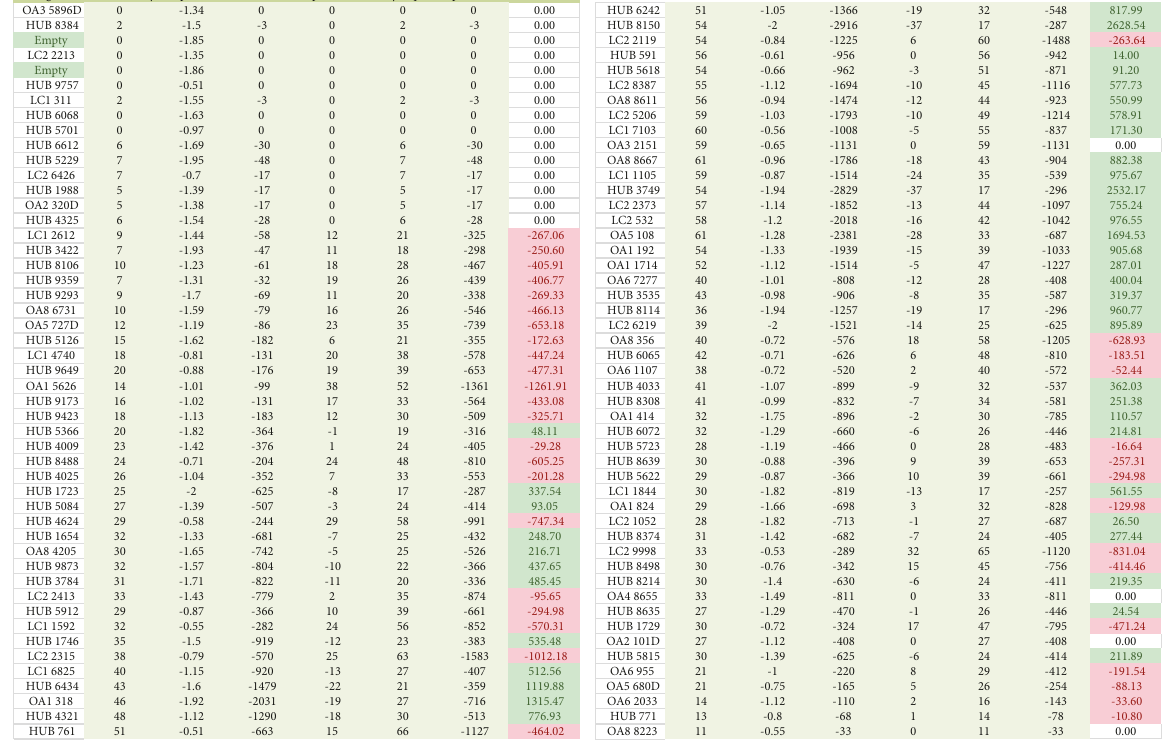
Figure 10: Schedule list with delay, costs, and optimal delay requested per flight (case study 1).